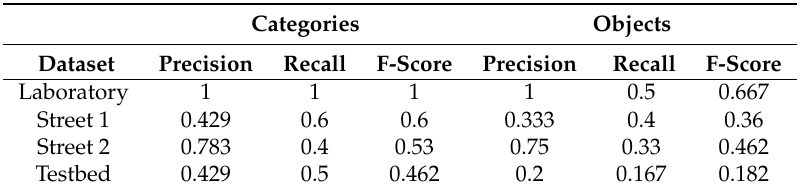
Table 2. Results of the object extraction